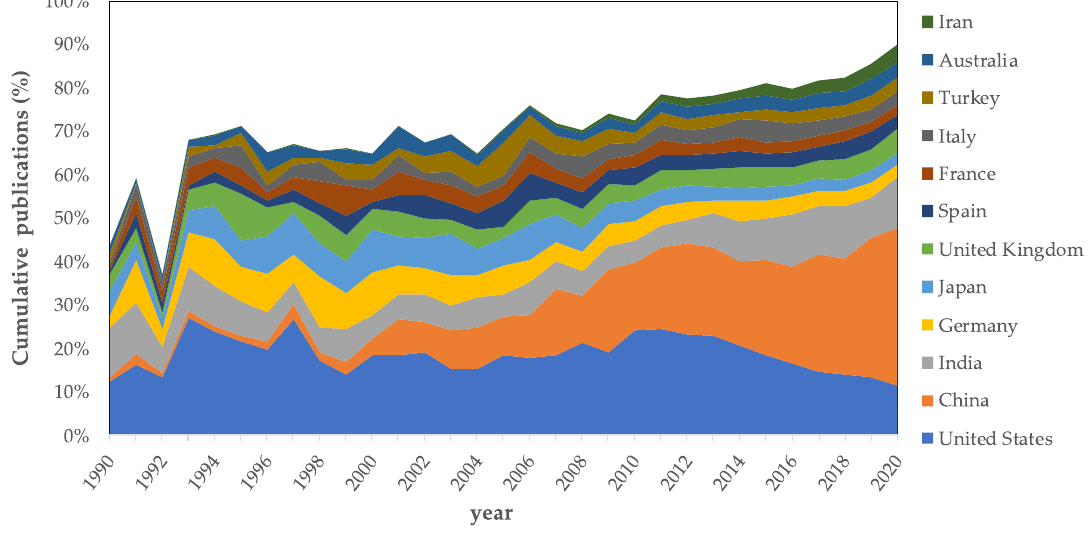
Figure 8. Publishing evolution of the most productive countries (from 1990–2020).